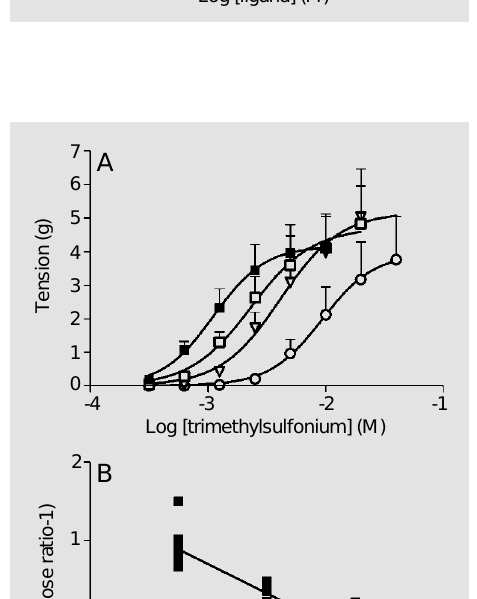
Figure 3. Inhibition of specific [ 3 H]-nicotine binding to mem- branes isolated from rat dia- phragm by unlabeled nicotine (filled squares, N = 8) or trimeth- ylsulfonium (open squares, N = 8). Membranes were incubated with [ 3 H]-nicotine and unlabeled compounds for 1 h at room tem- perature in Tris-HCl buffer. Spe- cific binding was calculated by subtracting the nonspecific bind- ing measured in the presence of unlabeled 10 mM nicotine from total binding (T). Data are re- ported as means ± SEM.